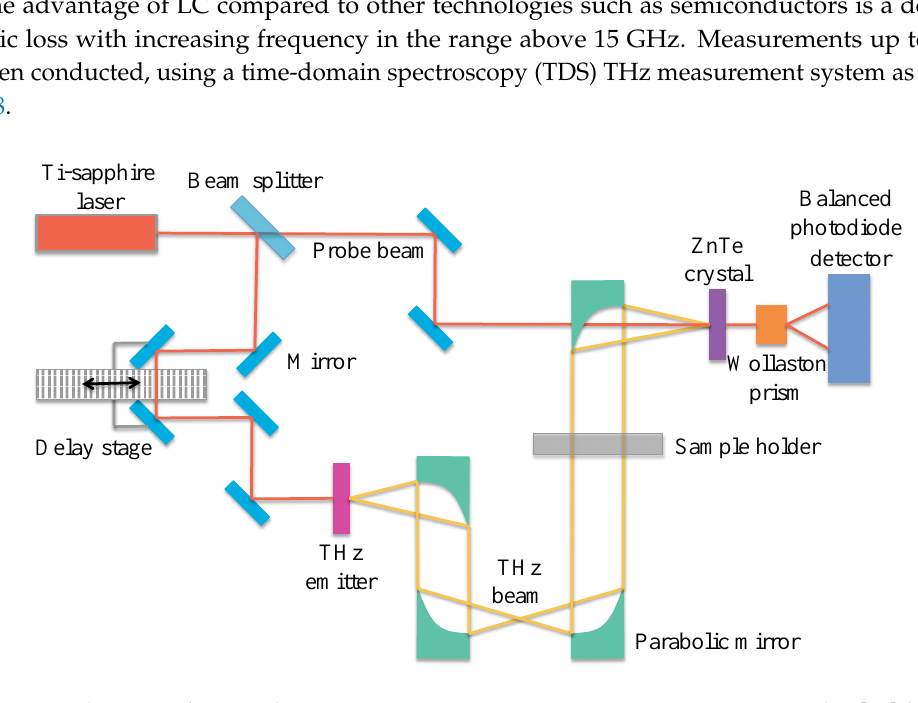
Figure 7. Development of LC’s microwave properties at 19GHz from the early 2000’s where first display LCs have been used towards recent LC mixtures specifically synthesized for microwave applications. The mixtures were measured at room temperature.